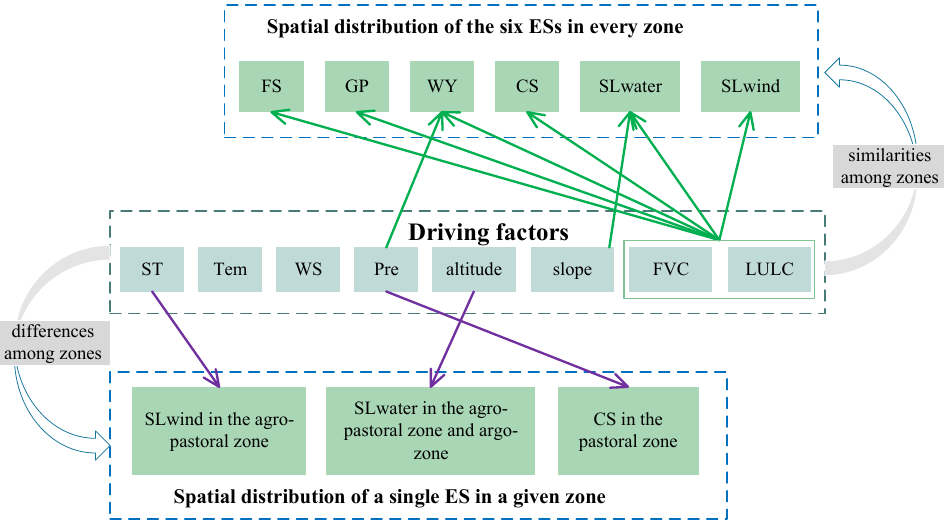
Figure 11. Important drivers of the spatial distributions of ESs in different zones. The drivers include precipitation (Pre), temperature (Tem), wind speed (WS), soil type (ST), altitude, slope, vegetation cover (FVC), and land use/cover (LULC). FS: food supply, GP: grass production, WY: water yield, CS: carbon sequestration, SLwater: soil water erosion, SLwind: soil wind erosion.